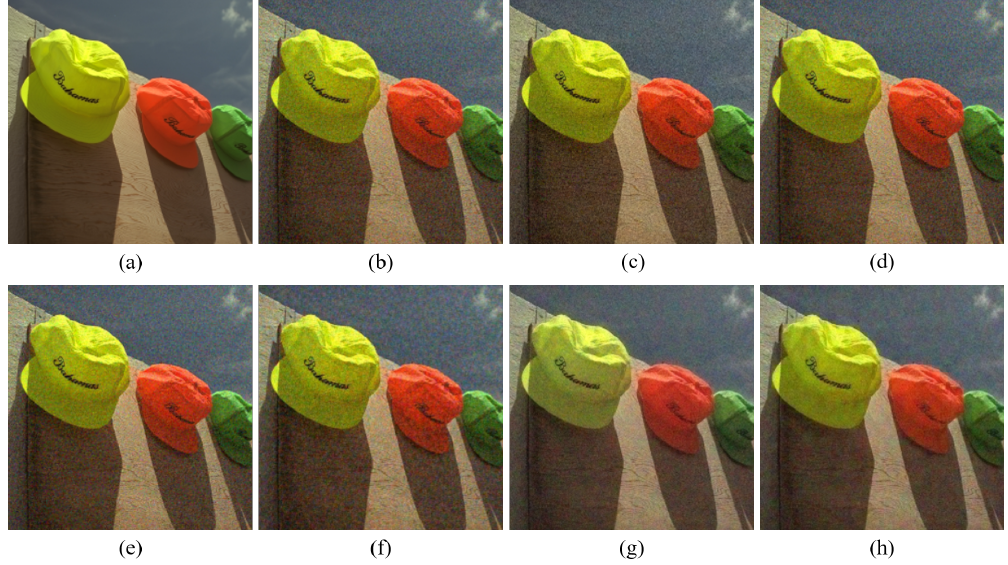
Figure 12. Demosaicing results of the Kodak No. 3 image under high-noise condition. ( a ) Original ( b ) ICC [12], ( c ) DNet [13] ( d ) RI [14] ( e ) ARI [15] ( f ) Sony [27] ( g ) Paul’s [36] ( h )